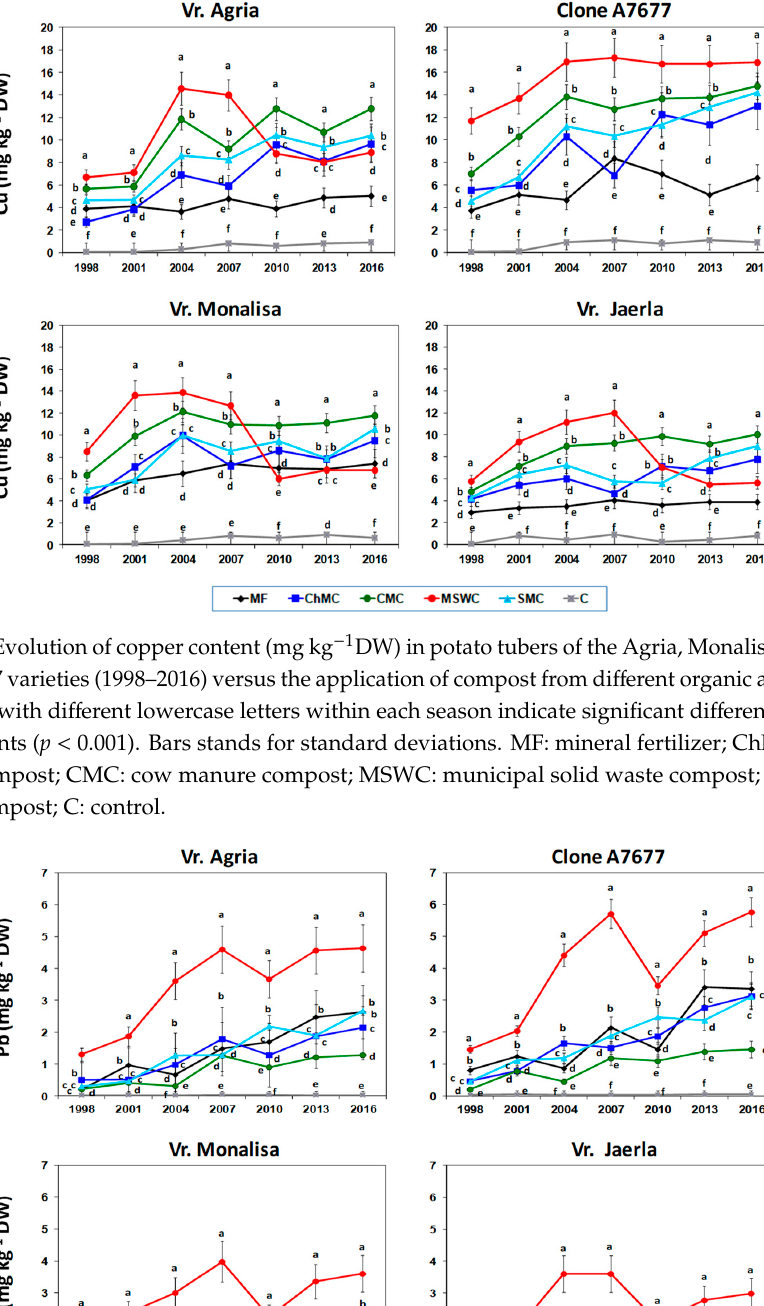
Figure 9. Evolution of zinc content (mg kg − 1 DW) in potato tubers of the Agria, Monalisa, Jaerla and clone A7677 varieties (1998–2016) versus the application of compost from different organic amendments. The means with different lowercase letters within each season indicate significant differences between the treatments ( p < 0.001). Bars stands for standard deviations. MF: mineral fertilizer; ChMC: chicken manure compost; CMC: cow manure compost; MSWC: municipal solid waste compost; SMC: sheep manure compost; C: control.